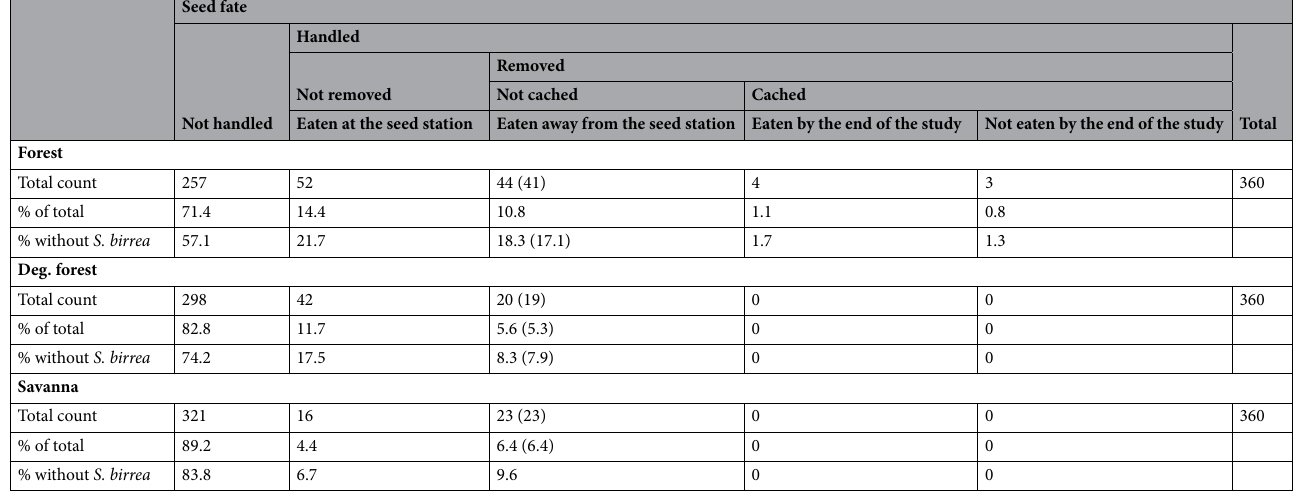
Table 1. Fates of thread-marked seeds in three vegetation formations of Oronjia, Madagascar. Since none of the seeds of Sclerocarya birrea were handled by animals, the results are also presented without this species. Values in brackets are seeds that had disappeared and were not found again and classified as